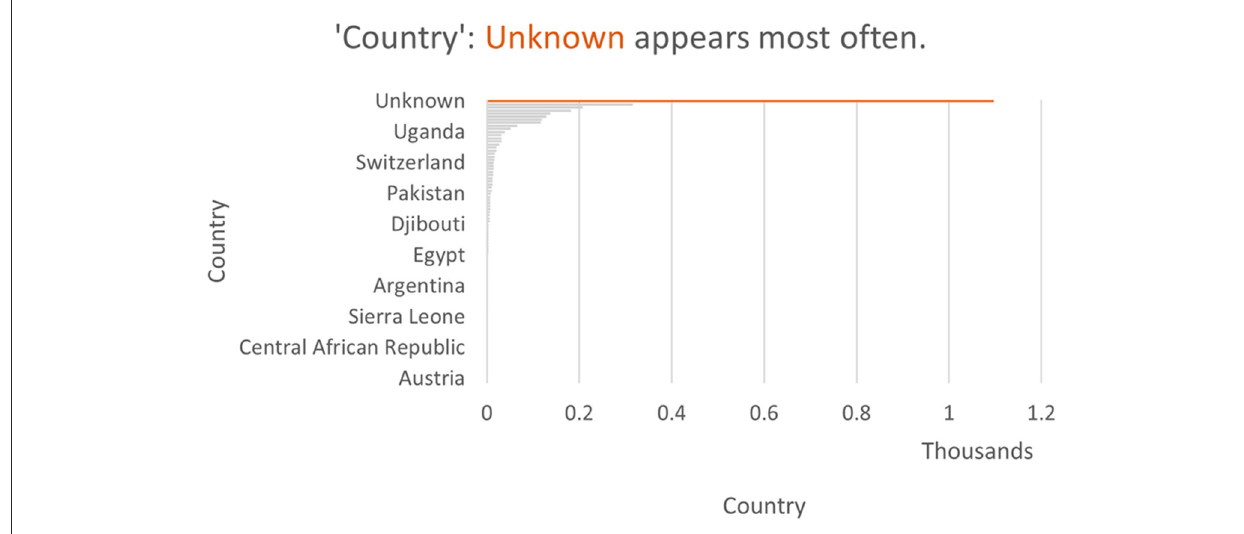
FIGURE6 The prevalence of different areas in the Twitter